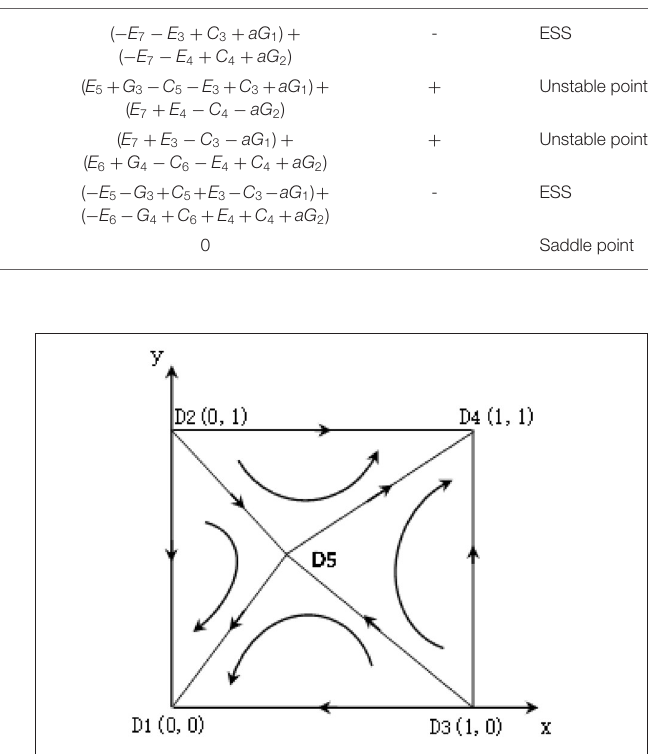
TABLE 2 | Local stability analysis results. Equilibrium point DetJ Tr result